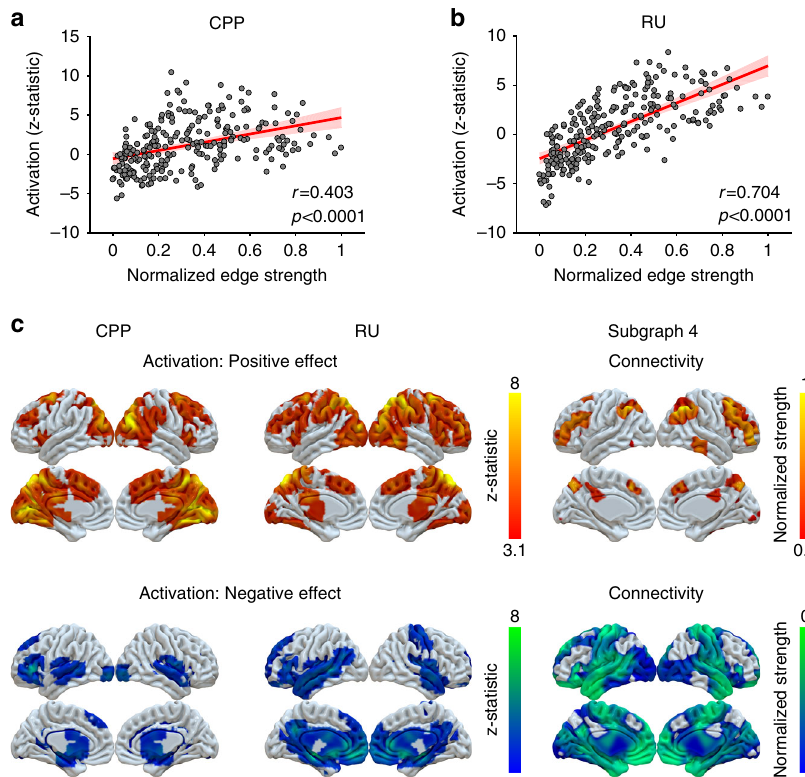
Fig. 6 Relationship between edge strength of subgraph 4 and univariate task activations. a Relationship between the activation for CPP and the edge strength of subgraph 4. We calculated the Pearson correlation coef fi cient between the z -statistic for CPP from McGuire et al. (2014) and the edge strength across nodes in subgraph 4. Each data point represents an ROI. The edge strength for each ROI was calculated as the column sum of that ROI ’ s edges to other ROIs, re fl ecting the summed interactions between that ROI and all others. The edges were normalized into the scale between 0 and 1. A signi fi cantly positive correlation was observed. The red line represents the regression line and the shaded area represents the 95% con fi dence interval. b Relationship between the activation for RU and the edge strength of subgraph 4. We observed a signi fi cant positive correlation between the z -statistic for RU from McGuire et al. (2014) and the edge strength across nodes in subgraph 4. The red line represents the regression line and the shaded area represents the 95% con fi dence interval. Source data of a , b are provided as a Source Data fi le. c Whole-brain thresholded activation maps for CPP and RU from McGuire et. al (2014) and whole-brain maps for edge strength of subgraph 4 in the current